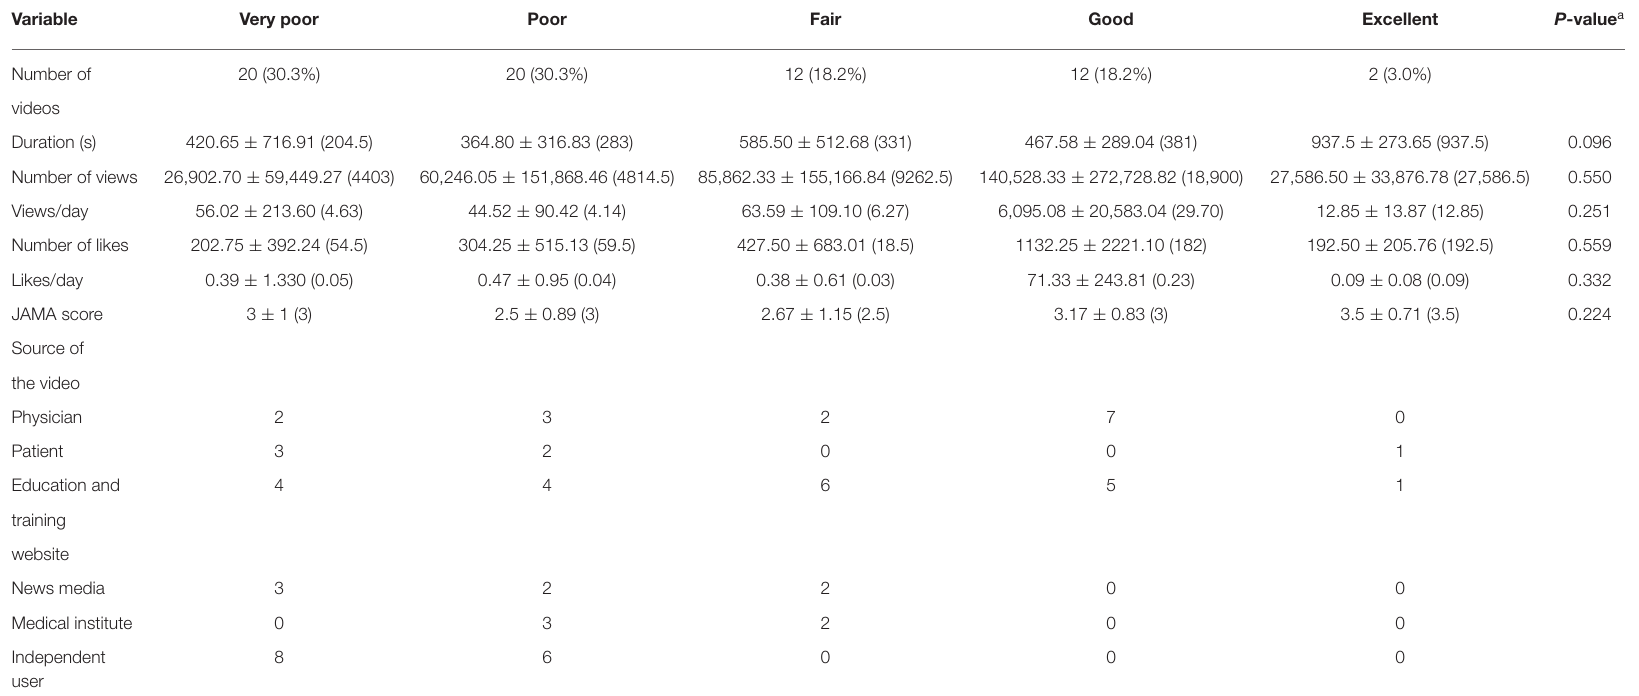
TABLE 5 | Distribution of DISCERN classification according to the video source and